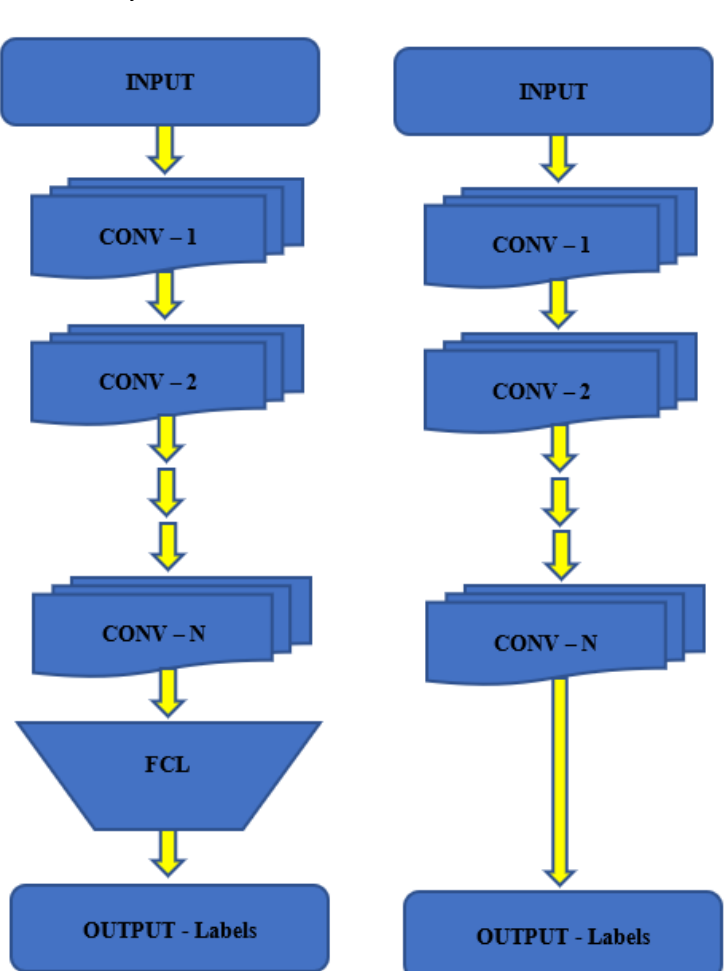
Figure 6. ( Left ): The original CNN network architecture. ( Right ): Removing the FC layers from CNN (this will serve as our extracted features).